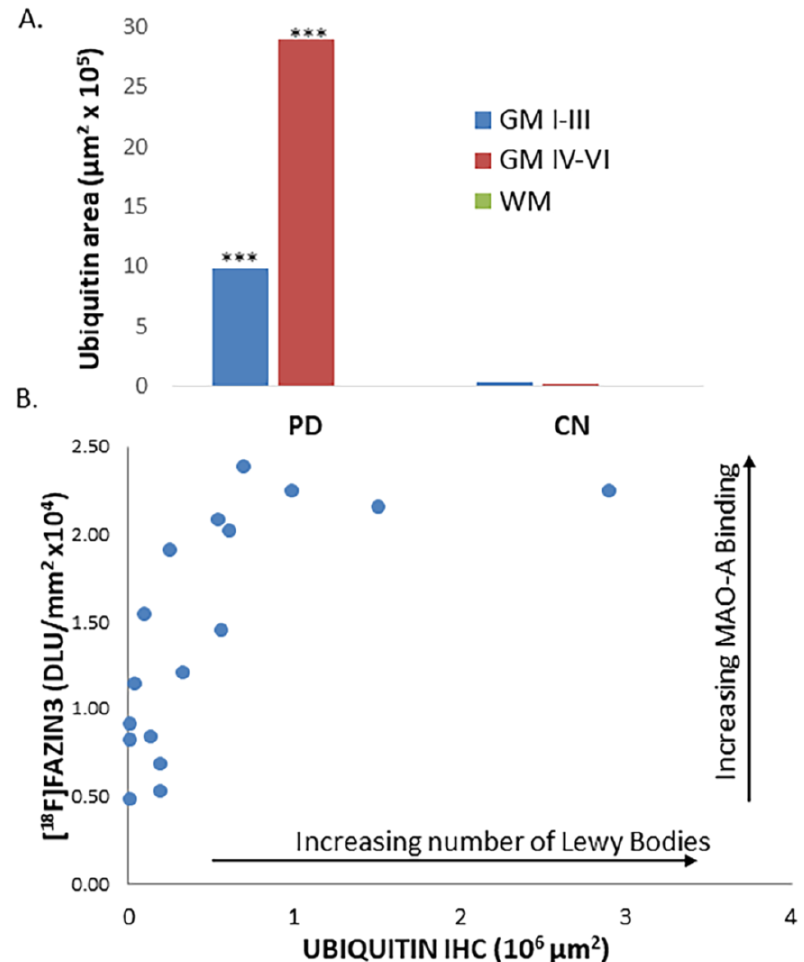
Figure 4. ( A ). Quantitation of LB in anti-ubiquitin stained brain sections of PD and CN subjects (*** p < 0.001 for cortical layers versus WM and CN GM). ( B ). Correlation plot of anti-ubiquitin and [ 18 F]FAZIN3 in all human subjects (Spearman’s correlation coefficient, ρ = 0.83 and p < 0.001). Plot shows an increase in [ 18 F]FAZIN3 binding to MAO-A present in the mitochondria surrounding the LB, with a plateauing effect at UIHC 10 6 μ m 2 .